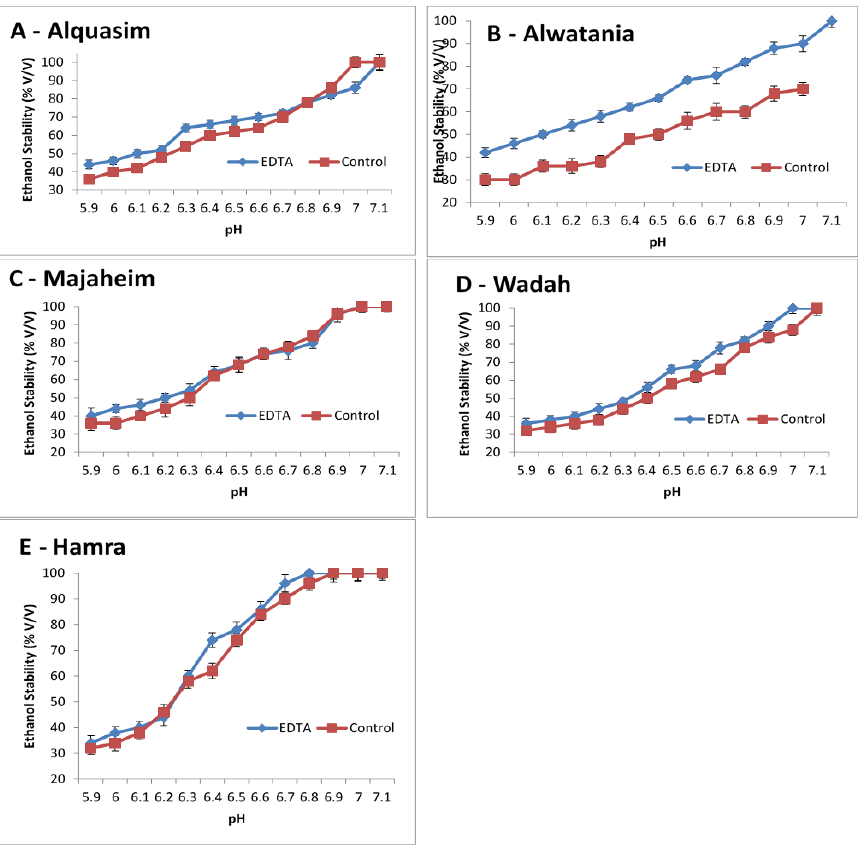
Figure 2. Changes in pH and ethanol stability of camel milk samples, Alquasim ( A ), Alwatania ( B ), Majaheim ( C ), Wadah ( D ), and Hamra ( E ) (ethanol stability: % ( v / v )). Error bars indicate the standard deviation.